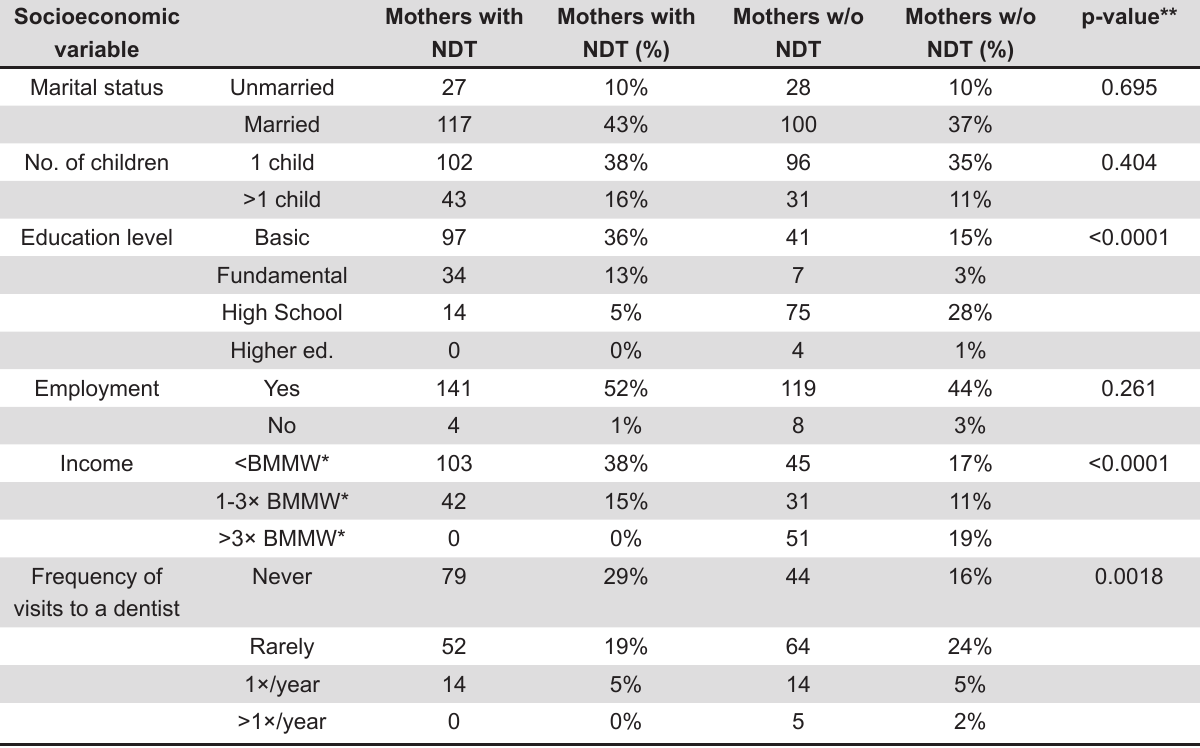
Table 1- Association between socioeconomic status and need for dental treatment (NDT) in mothers of 272 children enrolled in public institutions of early childhood education in southern